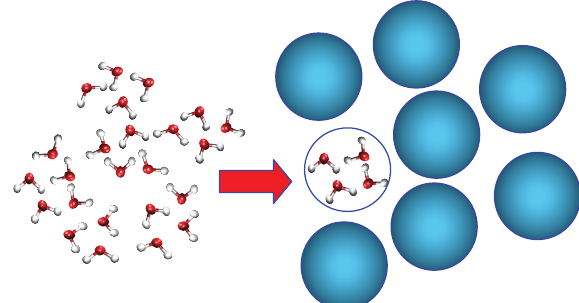
Figure 8: Illustration of the coarse-graining in DPD equal to four water molecules per DPD